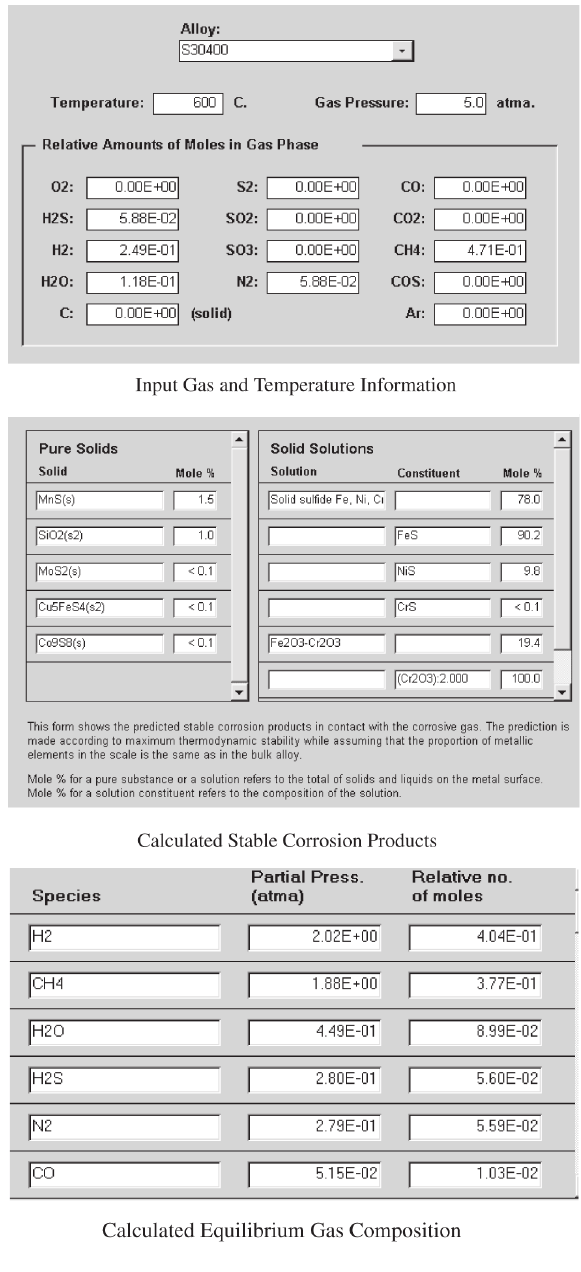
Figure 10. Example Screens for Alloy S30400 Exposed to a Com- plex Gas Analyzed to Predict the